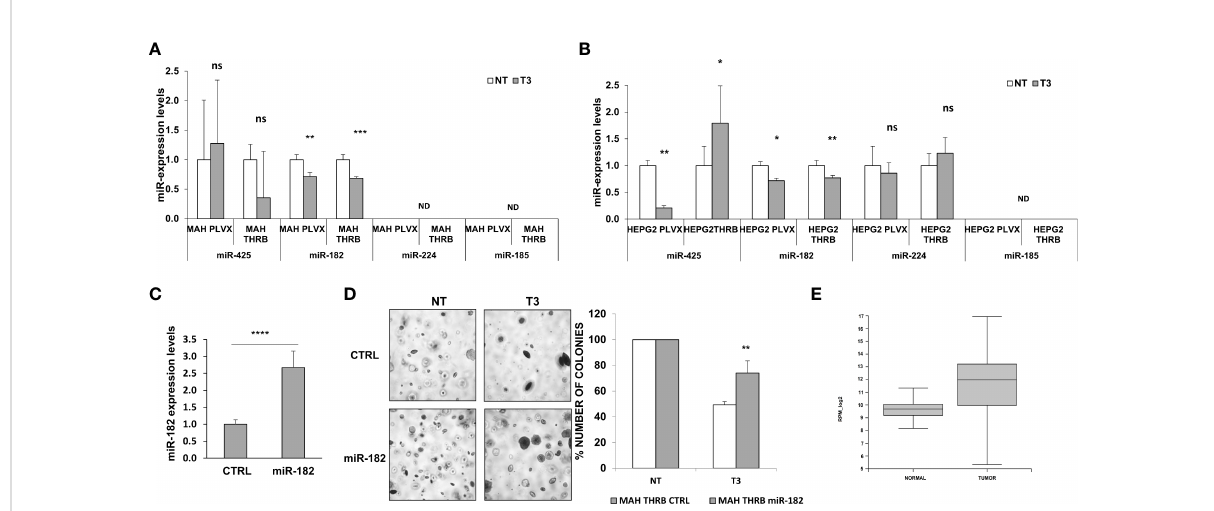
FIGURE 6 Expression of miRs in HCC cell lines and effect of miR-182 transfection on anchorage- independent growth of HCC cells. (A) Expression of miR-140, 185, 425 and 421, 224 and 182 in Mahlavu or (B) HepG2 cells not transduced (PLVX) or transduced with THRB and treated (T3) or not (NT) for 48 hours with 100nM T3. Each sample was run in triplicate and RNU48 was used as endogenous control. Relative quanti fi cation analysis for each gene was calculated by 2 - DD Ct method; ND: not detected. Values are expressed as mean ± SD; (C) qRT-PCR analysis of miR-182 following transfection of Mahlavu THRB cells. RNU48 was used as endogenous control. Relative quanti fi cation analysis for miR-182 was calculated by 2 - DD Ct method. Student t-test: *** P <0.001. Values are expressed as mean ± SD; (D) Anchorage ‐ independent growth of Mahlavu THRB cells described in (A) Visible colonies were counted after 15 days (Left), and Graph representing the number of colonies of Mahlavu THRB cells described in A stably transduced with miR-182 or a control (shSCR) and grown in anchorage-independent conditions (Right). Student t- test: * P < 0.05; ** P < 0.01; *** P < 0.001. Values are expressed as mean ± SD; (E) Relative expression of mir-182-5p in normal and tumor group in TCGA (the blue represents normal group, the orange represents tumor group). The expression level is represented in RPM_log2 values. Mann-Whitney U-test: ****P < 0.0001. The expanded form of "ns" is: not signi fi